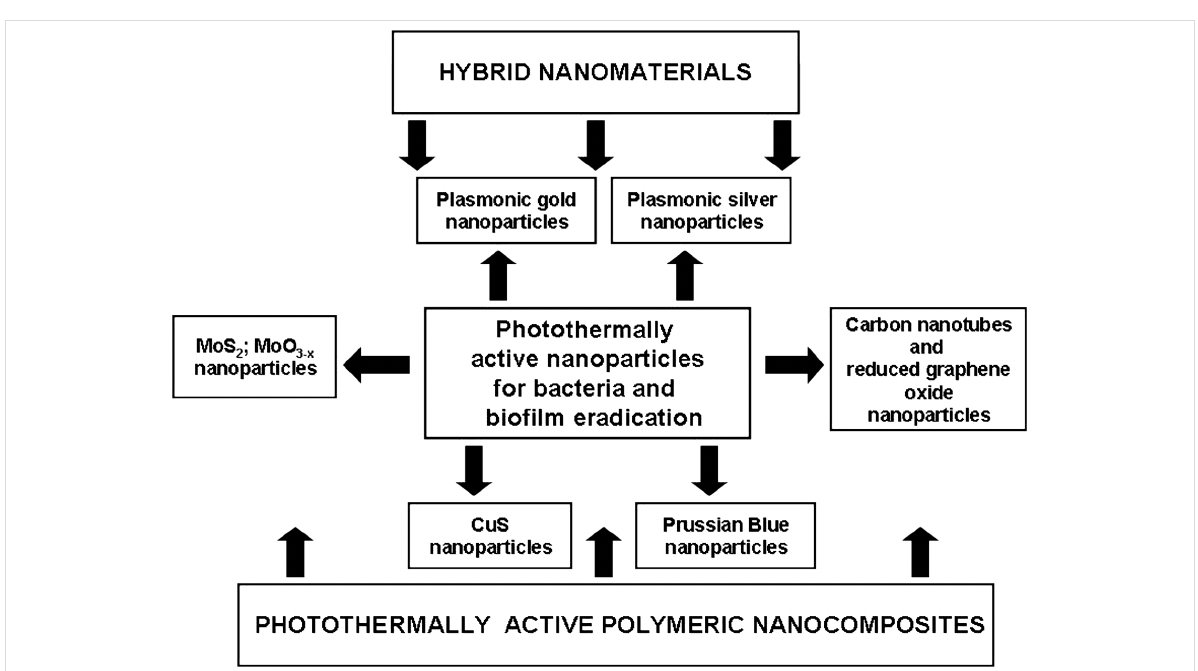
Figure 2: Schematic showing the relationship between photothermally active nanoparticles and nanocomposites for bacteria and biofilm eradication.